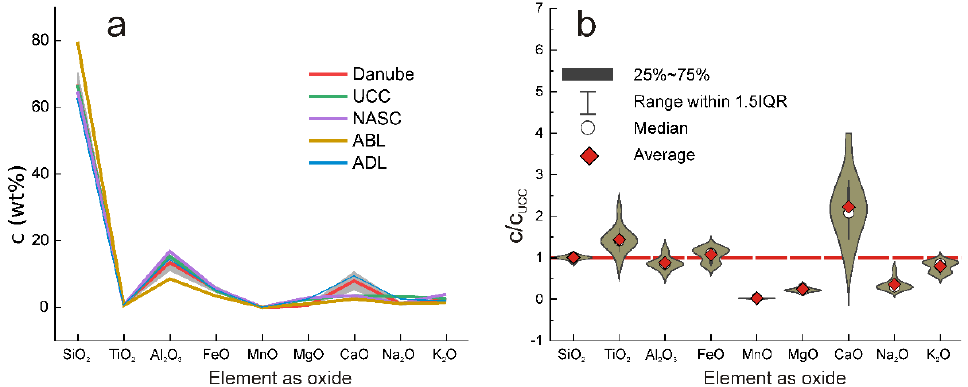
Figure 2. Spider ( a ) and violin ( b ) diagrams illustrating the mass fraction distribution of major elements (as oxides). In the case of violin diagrams, all mass fractions were normalized to the UCC [22] values.